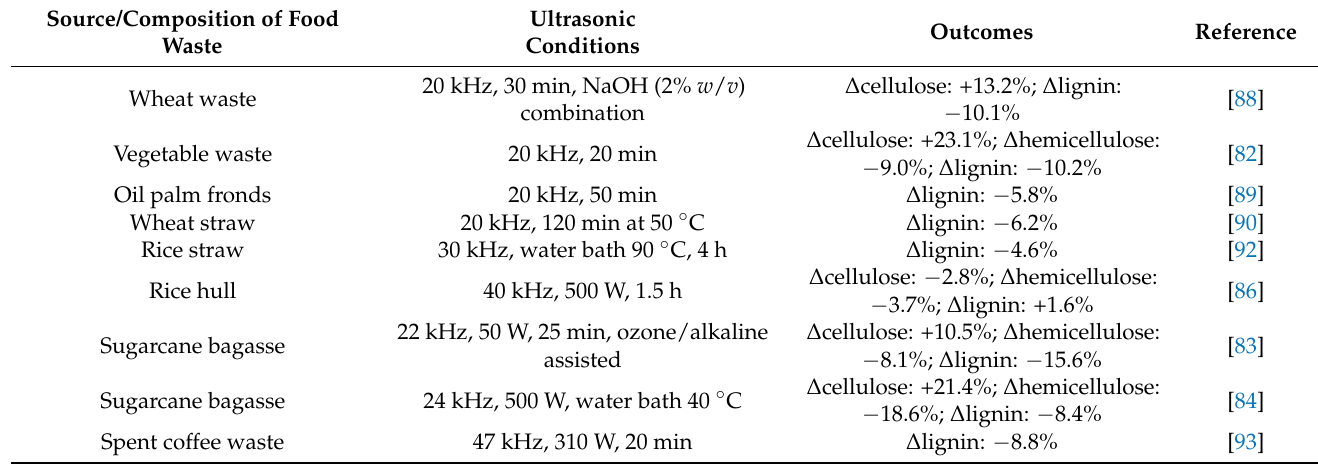
Table 2. The variation in the amounts of cellulose, hemicellulose, and lignin in an extract after ultrasonic